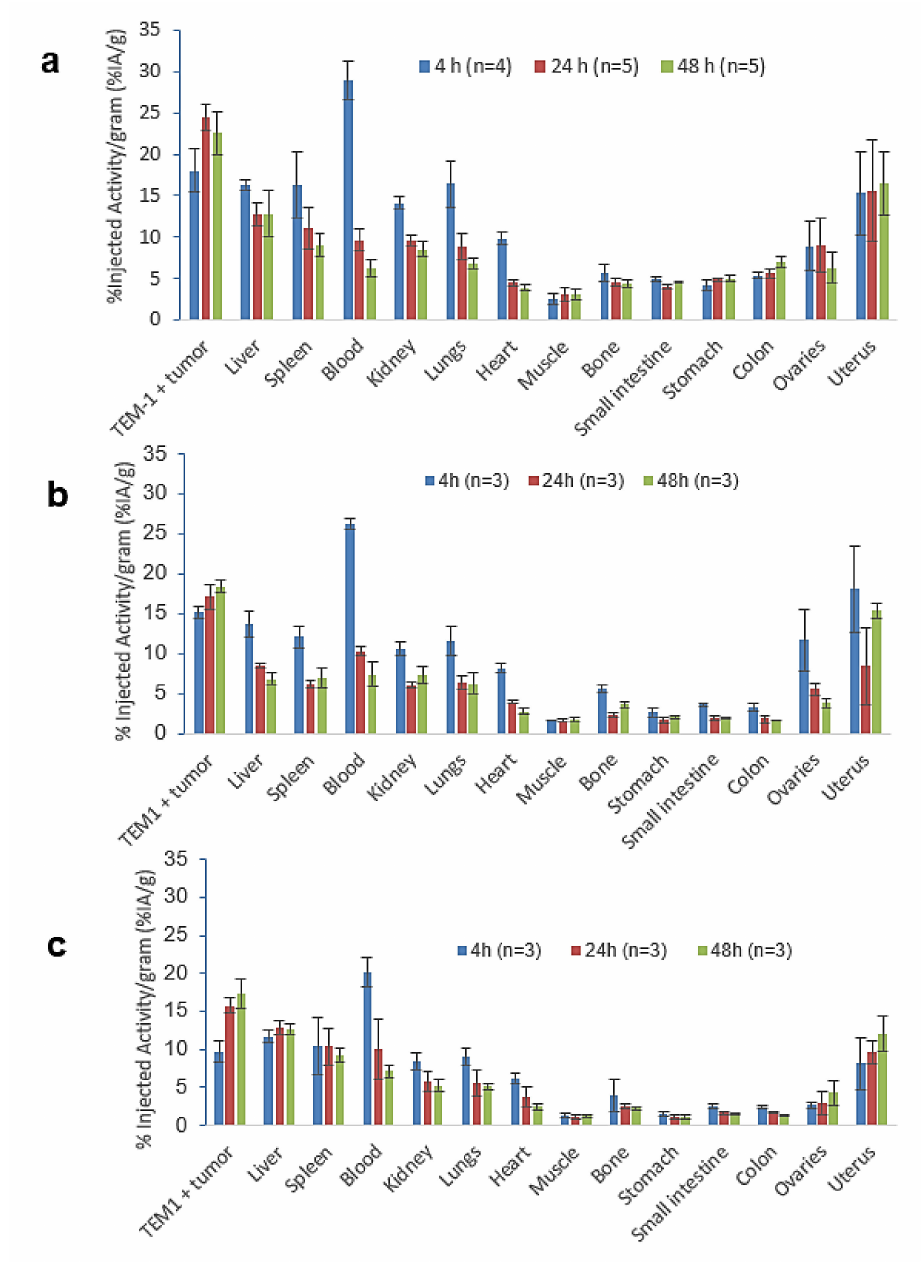
Figure 4. Biodistribution in BALB/c nude mice bearing TEM-1-positive tumor of ( a ) [ 64 Cu]Cu- 4DOTA-1C1m-Fc, group 1; ( b ) [ 177 Lu]Lu-1DOTA-1C1m-Fc (data from Delage et al. [28]; ( c ) [ 177 Lu]Lu- 3DOTA-1C1m-Fc (data from Delage et al. [27]). The total antibody dose used for this biodistribution was 50 µ g. Data are shown as mean ±